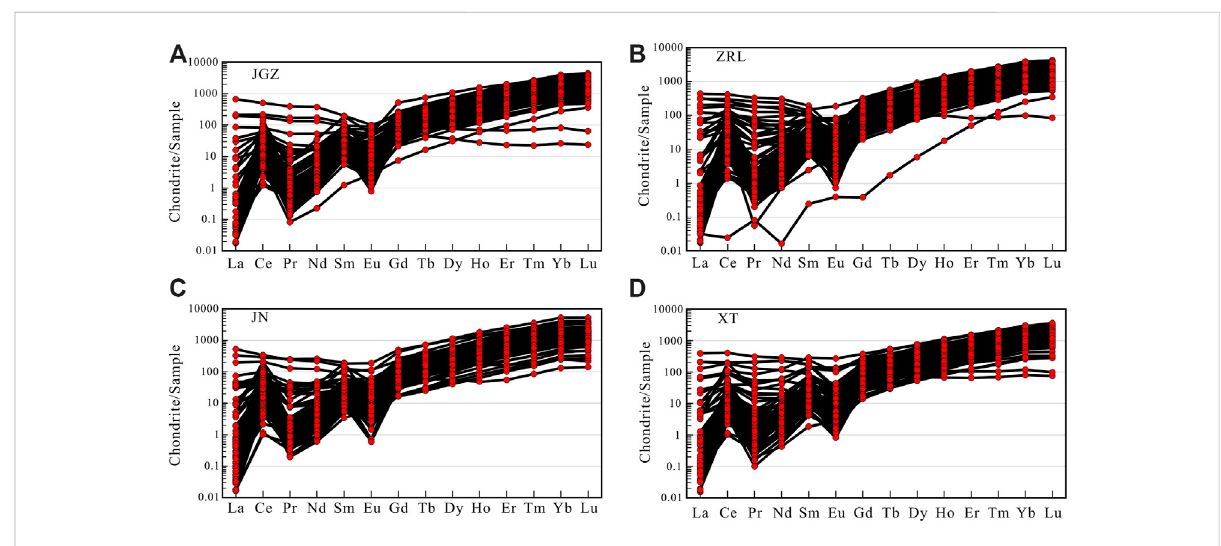
FIGURE 9 Chondrite-normalized REE patterns for the analyzed zircon grains (normalized value after Boynton, 1984; samples (A, B, D) from the western Shandong province, and sample (C) from the Tanlu fault zone).